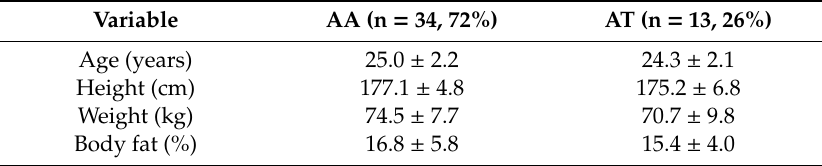
Table 1. Subject characteristics according to the myostatin A55T genotype.